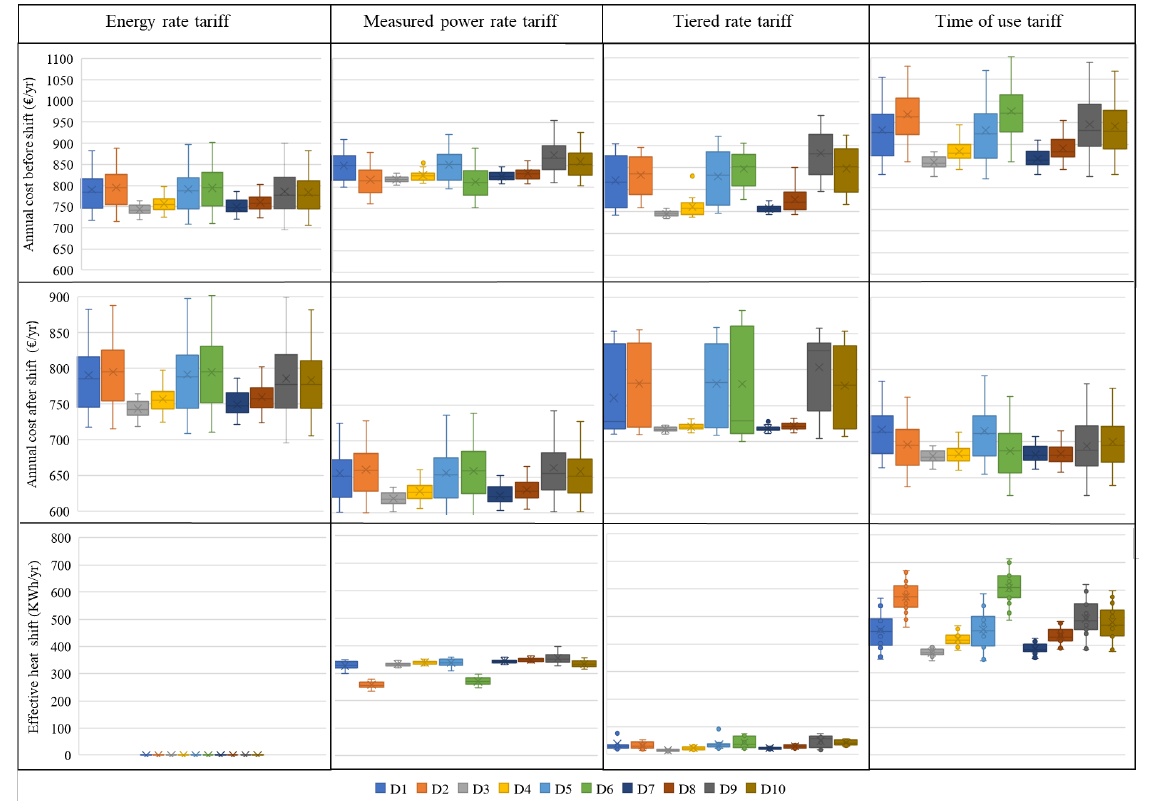
Figure 7. Annual costs (before and after shifts) and effective shifts for the ten designs across 16 scenarios and the differ- ent